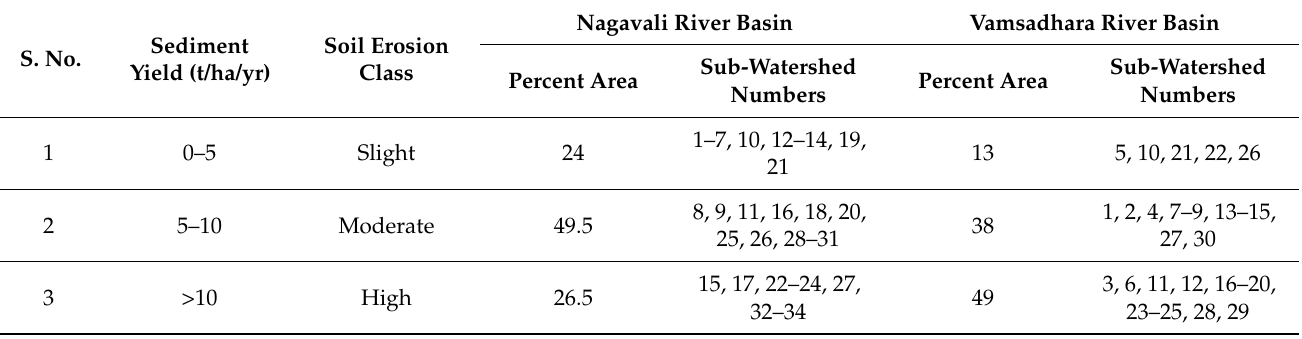
Table 7. Areas subjected to various levels of soil erosion in the Nagavali and Vamsadhara basins.